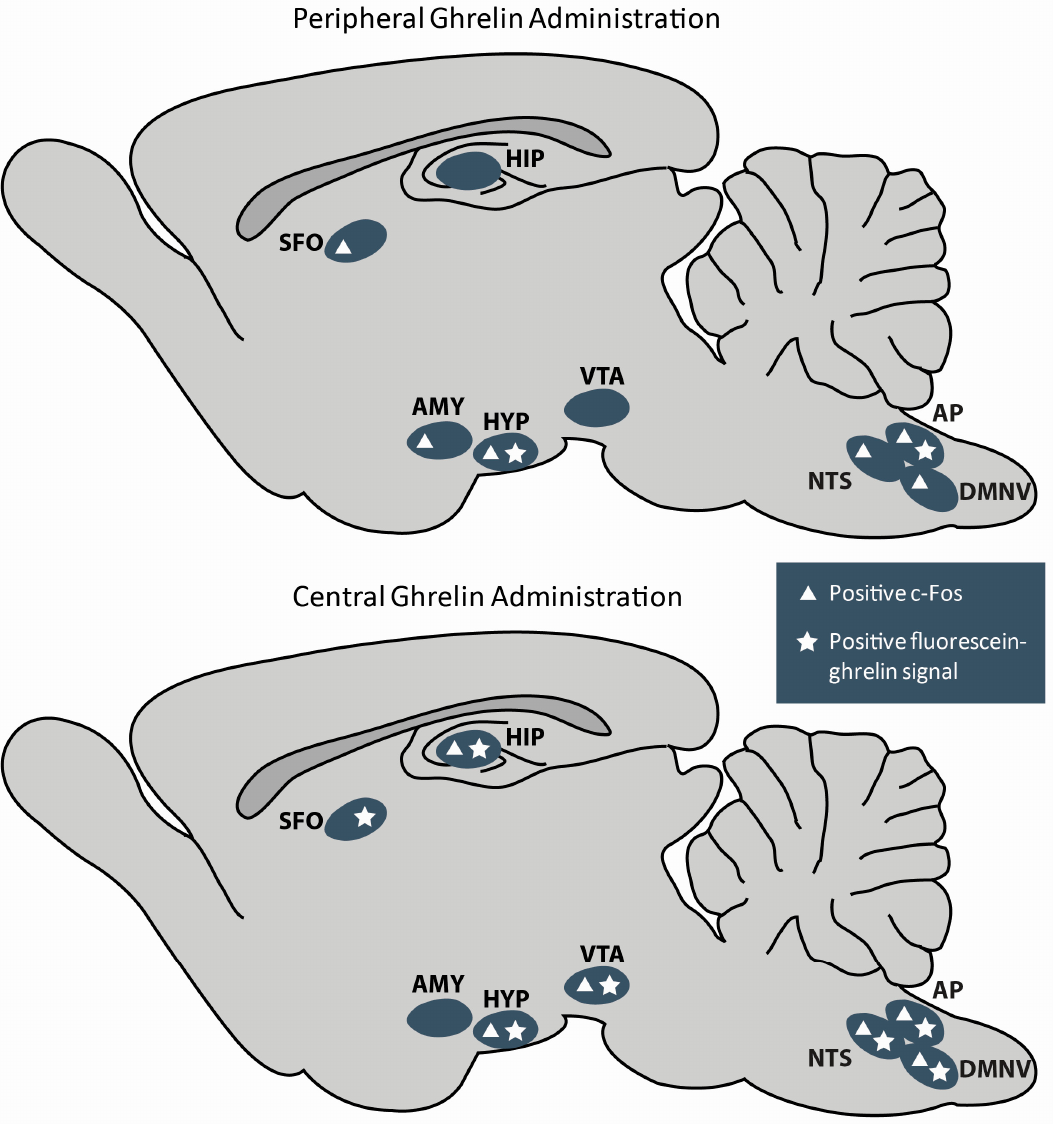
Figure 3. Illustration of the feeding related brain regions that demonstrate positive c-Fos and/or fluorescein-ghrelin signals following peripheral and central ghrelin administration. Fluorescein ghrelin is a probe that has been used to determine what brain regions normal acylated ghrelin accesses. It is a fluorescently tagged (fluorescein isothiocyanate) truncated analog of the ghrelin peptide (i.e., 18 amino acids) with equivalent receptor stability, agonist activity, and binding affinity as acylated ghrelin [133]. AMY, amygdala; AP, area postrema; DMNV, dorsal motor nucleus of the vagus nerve; HIP, hippocampus; HYP, hypothalamus; NTS, nucleus tractus solitaries; SFO, subfornical organ; VTA, ventral tegmental area.